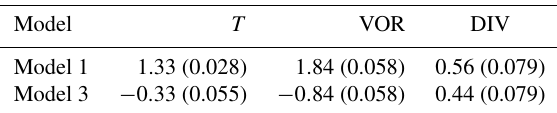
Table 5. Weights for the supermodel trained by CPT allowing for negative weights. The standard deviation over the year is given in